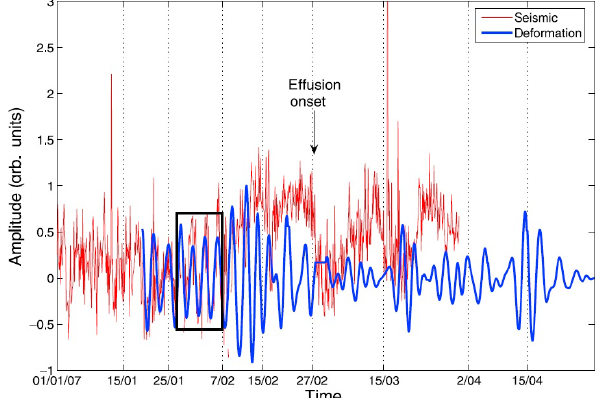
Figure 3. Comparison between the amplitude of the seismic signal (red line) and the deformation (blue line) filtered in the range [2– 4]d. Both the signals were normalized to facilitate the comparison. Dilatometer’s recording starts on January 19th. In this representa- tion, the match between the curves evidenced by a black rectangle covers the period 19 January–7 February, when an increase of the explosions’ amplitude occurs leading to the effusion (after De Mar- tino et al.,